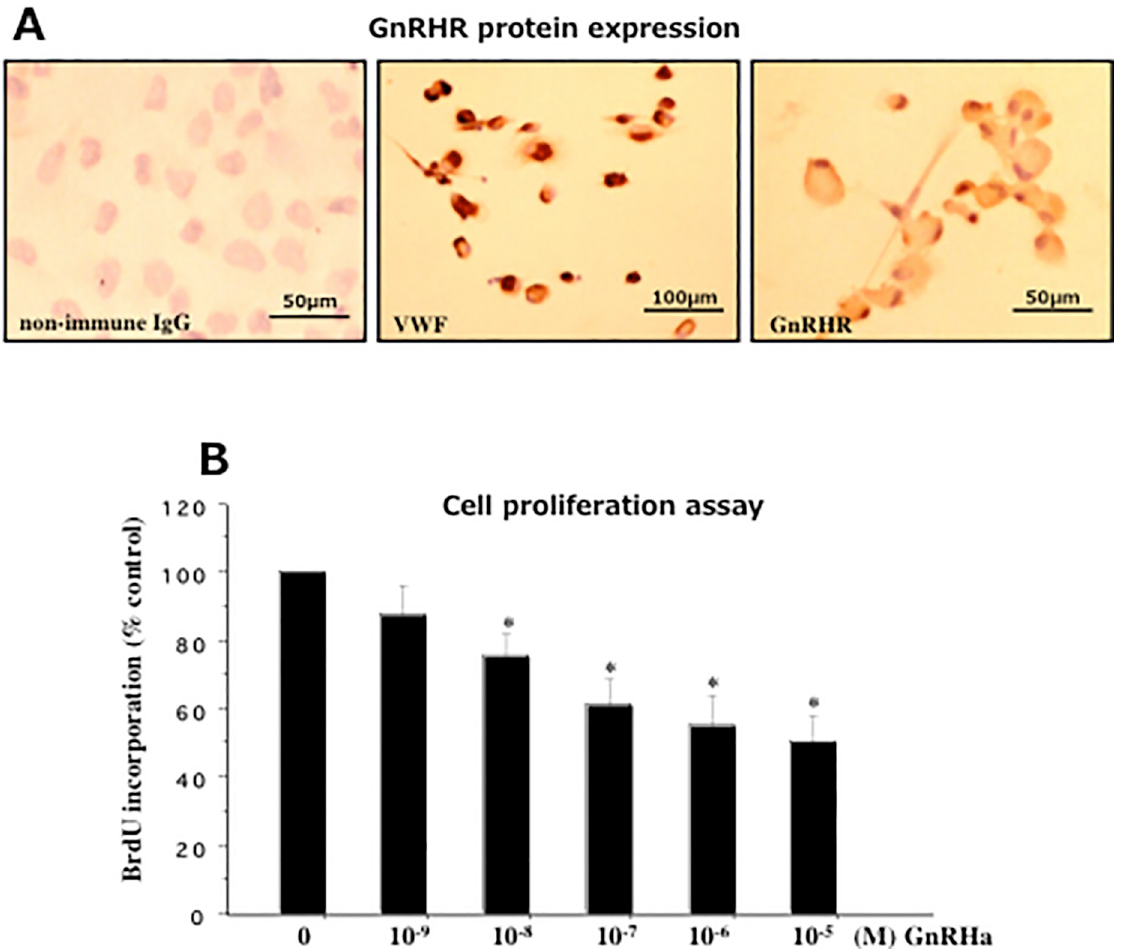
Fig 4. (A) Immunohistochemical staining of von Willebrand factor (VWF, middle slide) and gonadotropin-releasing hormone receptor (GnRHR, right slide) in vascular endothelial cells derived from human umbilical vein (HUVECs). The protein expression of GnRHR was detected in VWF-immunostained HUVECs. Non-immune IgG-stained HUVECs is shown as a negative control (left slide). ( B ) Effect of gonadotropin-releasing hormone agonist (GnRHa, leuprolide acetate) on BrdU incorporation into HUVECs. Both GnRHa-treated and non- treated cells were incubated for 48h. Results are expressed as the mean percentages of the untreated cells ( ± SEM) of triplicate experiments using cells derived from HUVECs. � p < 0.05 for each indicated dose (10 -8 M to 10 -5 M) of GnRHa-treated versus -untreated cells.